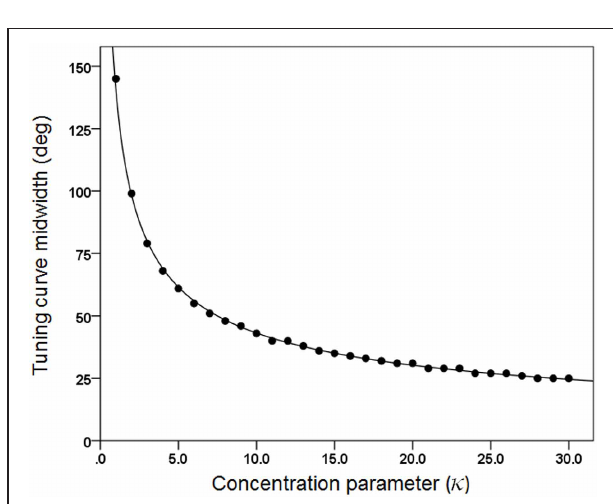
FIGURE 3 | The average directional variable error of the 1000 population vectors is plotted against κ . The fitted line is a power function fit ( R 2 = 0 . 957). N =